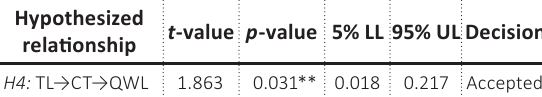
Table 5. Mediation effect